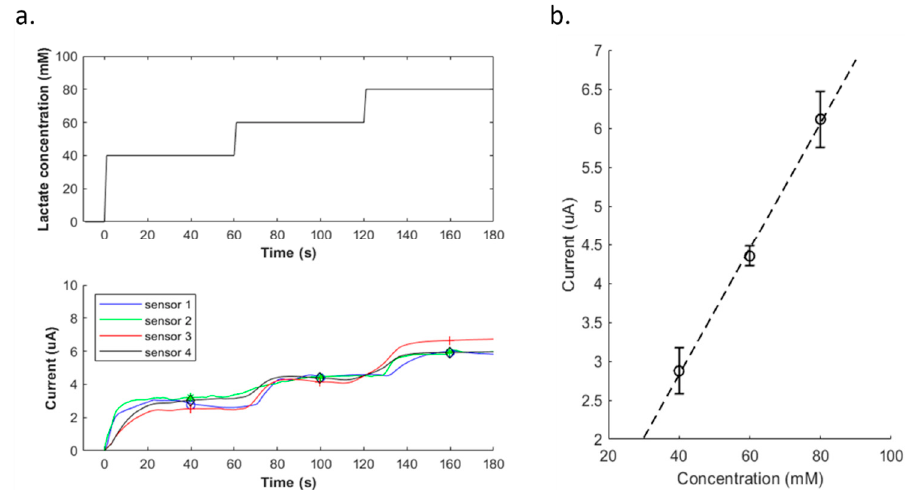
Figure 10. Calibration example by using a standard addition method. The experimental values have been obtained for a flexible lactate biosensor. In subfigure ( a ) the concentration changes applied are presented in the top graph and the measured output current in the bottom-left graph with the points (diamonds) at which the steady-state current value is measured. In subfigure ( b ) the corresponding calibration curve obtained is reported.